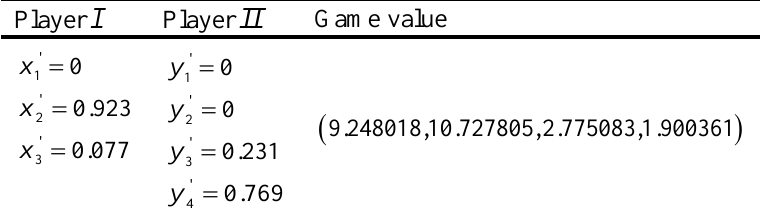
Table 2. The optimal fuzzy